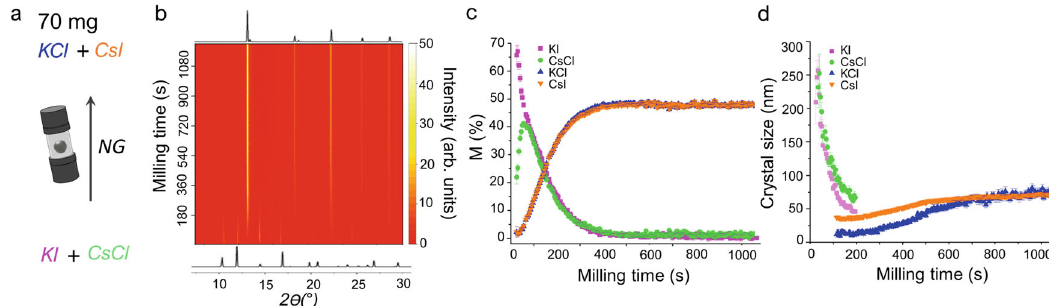
Fig. 3 TRIS-XRPD for Reaction I under ball mill neat grinding (NG) conditions with a loading of 70 mg. a The reaction scheme for Reaction I under NG conditions. b Heat maps (linear intensity, arb. units) of TRIS-XRPD with empirical background subtracted data for Reaction I, alongside calculated 1D XRPD patterns for the reagents (KI + CsCl) and the fi nal products (KCl + CsI). c Quantitative phase analysis for Reaction I obtained by Rietveld re fi nement, showing the consumption of KI (pink) and CsCl (green), with simultaneous formation of KCl (blue) and CsI (orange) with relative ESD bars. d Scherrer crystal size obtained for KI (pink), CsCl (green), KCl (blue) and CsI (orange) with relative ESD bars are shown for phases more abundant than